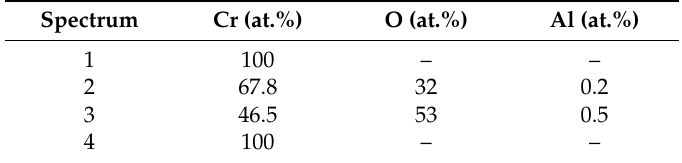
Table 2. Chemical composition as obtained by EDS point analysis at locations shown in Figure 10.